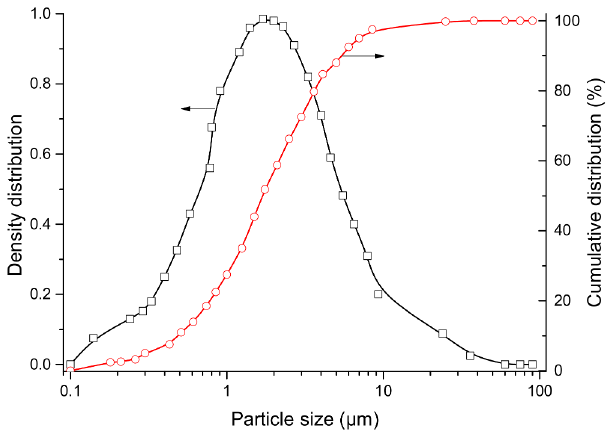
Figure 1. Particle size distribution of metakaolin.